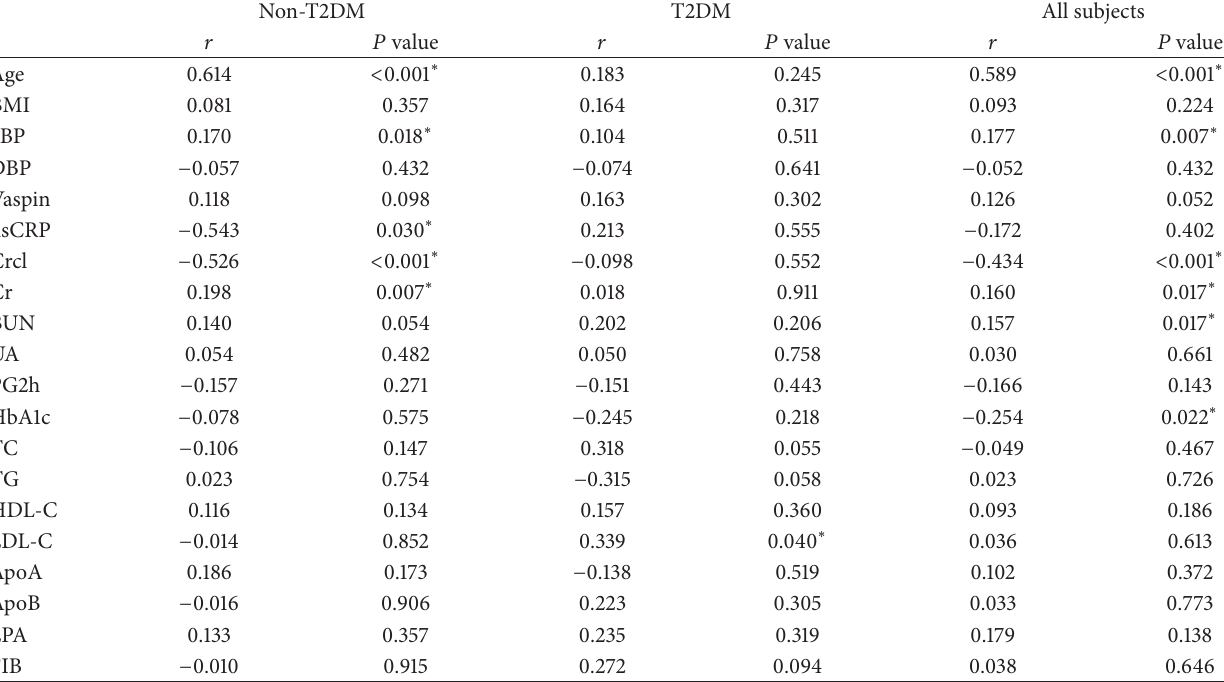
Table 4: Single univariate linear correlations of factors associated with serum adiponectin levels.